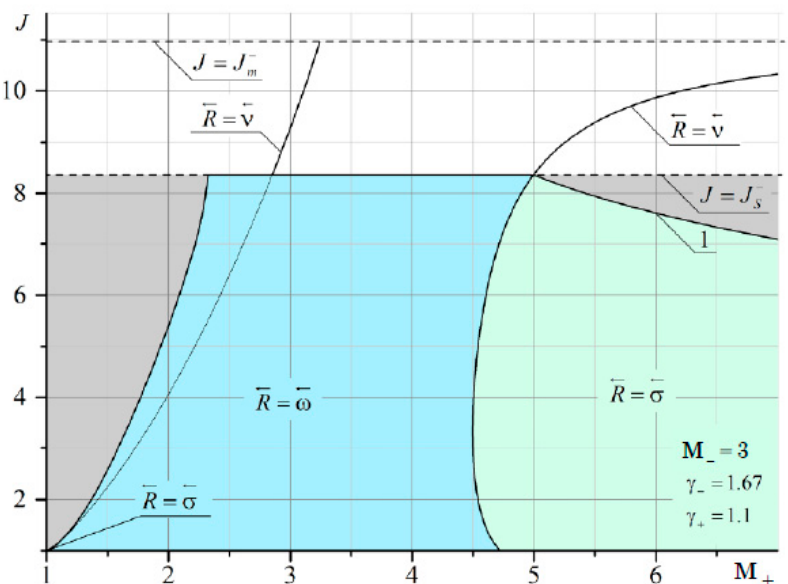
Figure A11. Domains of existence of reflected discontinuities for refraction from a monatomic gas into a gas consisting of combustion products. The Mach number of the flow from which the shock comes is M – = 3. The domains of existence of reflected discontinuities for refraction from a monatomic gas into a gas consisting of combustion products at the Mach number of the flow M – = 5 are shown in Figure